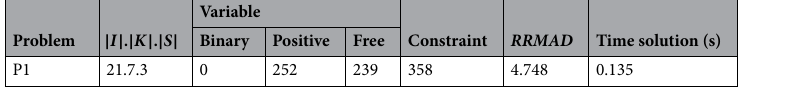
Table 3. Sets, variables, and constraints, for the case study.